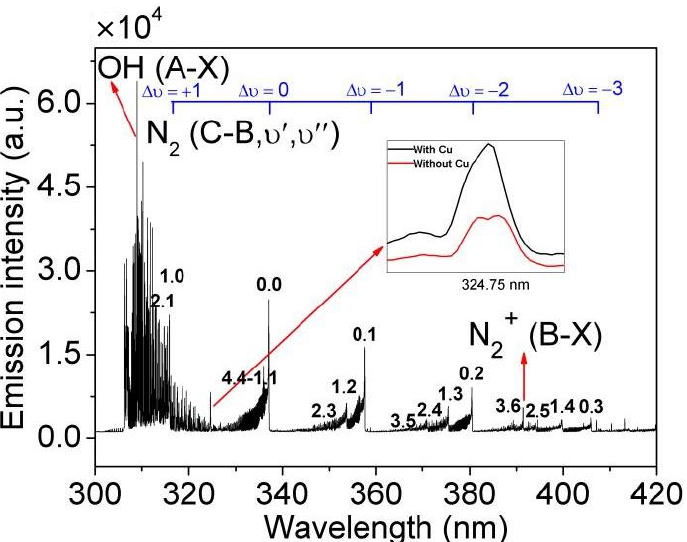
Figure 4. Typical spectrum of 1 mg/L Cu 2+ in the range of 300 – 420 nm (applied voltage: 6.2 kV, Ar flow rate: 2.1 L/min, no organic matter and nitric acid added).